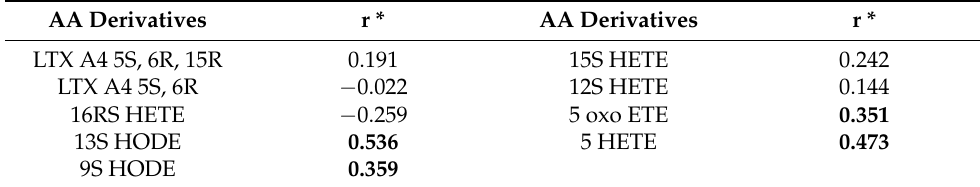
Table 3. Correlations between potassium levels and arachidonic acid (AA)